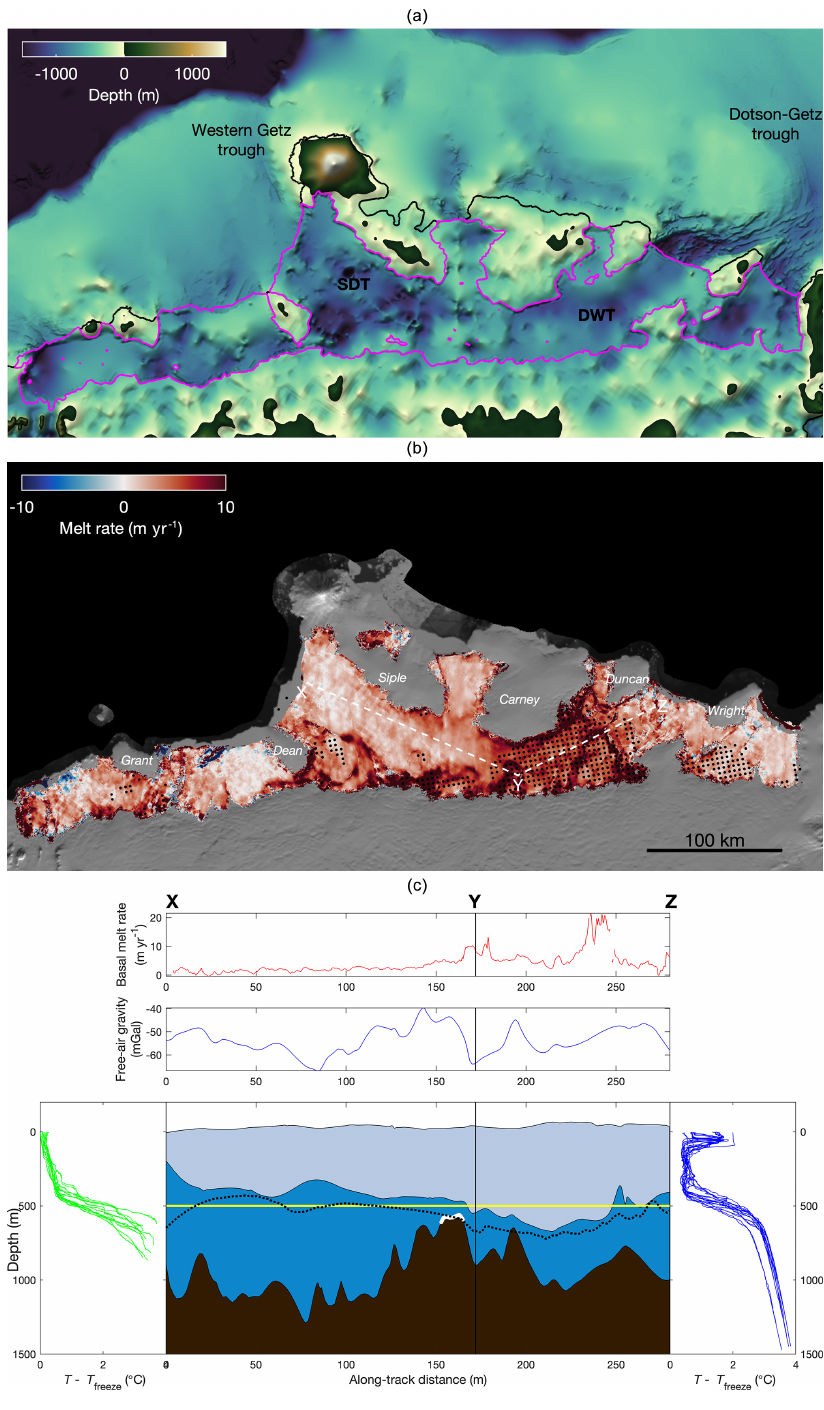
Figure 2. The shape of the seafloor, basal melt rates, and along-profile view of the study area. (a) The bathymetry of the Getz Ice Shelf. The profile XYZ crosses the trough between Dean Island and Siple Island, the bathymetric sill, and the trough between Duncan and Wright Islands. The purple is the ice shelf outline (Mouginot et al., 2017). The bathymetry of the continental shelf is from IBCSO (Arndt et al., 2013). (b) The observed basal melt rate. Black stippling indicates ice bottom elevations that are below the 500m depth of the thermocline. The background is the MODIS-derived Mosaic of Antarctica (MOA; Scambos et al., 2007). (c) Upper panel shows the basal melt rate along profile XYZ. The lower panel shows the elevations of ice and bedrock along profile XYZ, with the depth–temperature profiles from western and eastern Getz. Ocean is blue; ice is light blue, and the bedrock is brown. The white indicates the location of the bathymetric sill. The dashed black line is the bathymetry from Bedmap2 (Fretwell et al., 2013). The horizontal yellow line indicates the mean thermocline depth. The thermal forcing T − T freeze is calculated from CTD casts (Locarnini et al.,